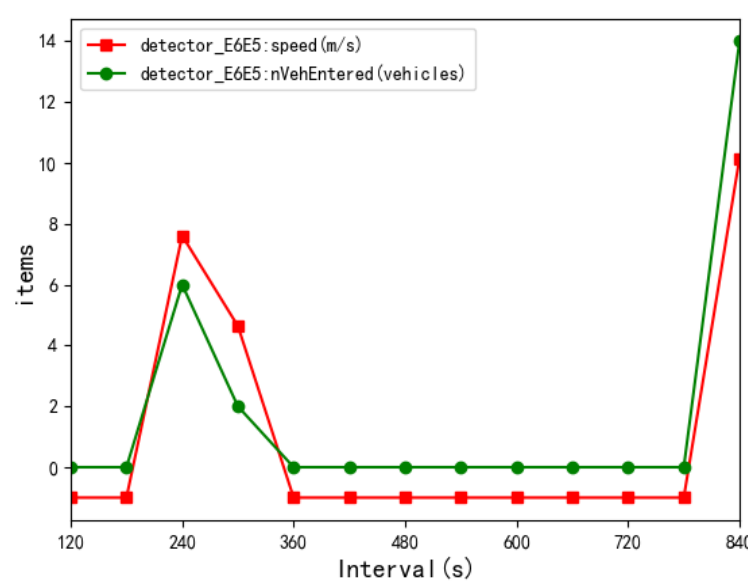
Figure 22. Output data (speed and nVehEntered) collected by E1 on lane E6E5.